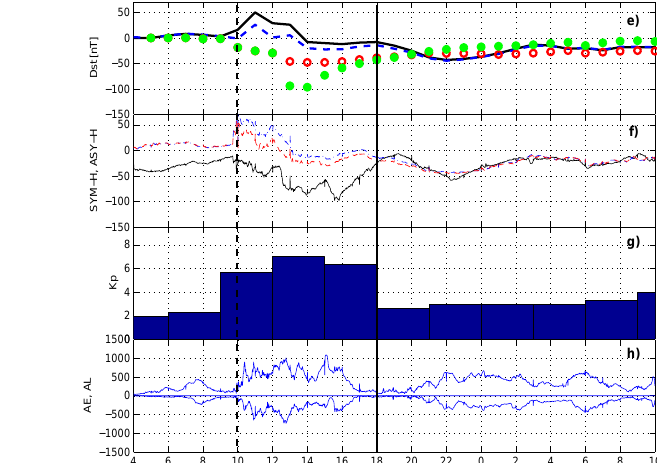
− 700 nT. During the period of the strong high-latitude ac- tivity, D ∗ and SYMH stayed around the quiet level. st